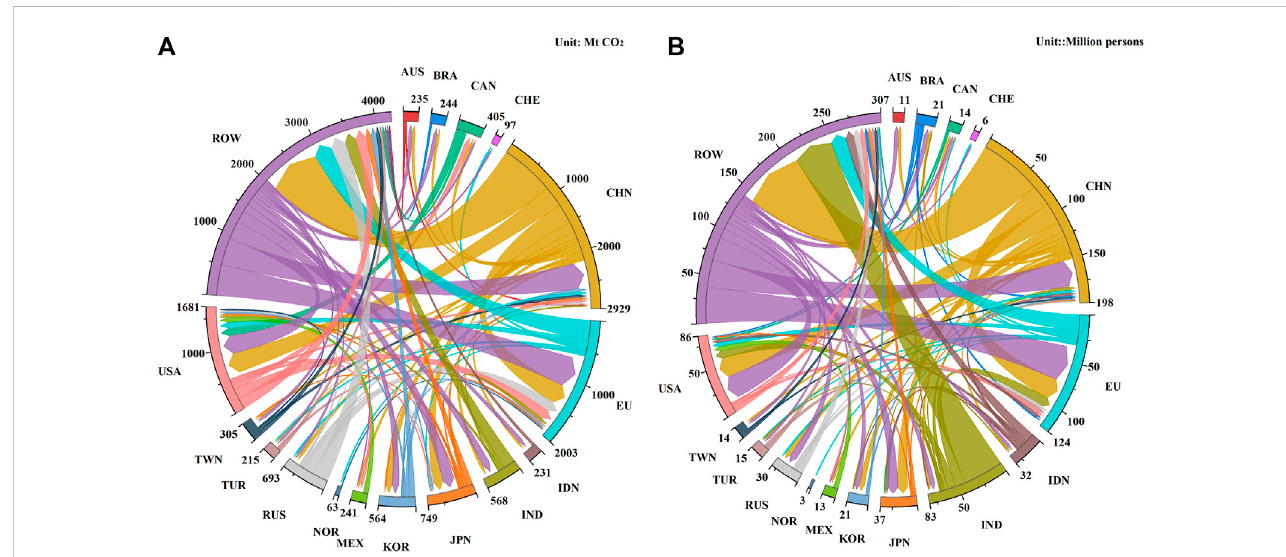
FIGURE 4 Transfers of embodied carbon emissions (A) and employment (B) in international trade in